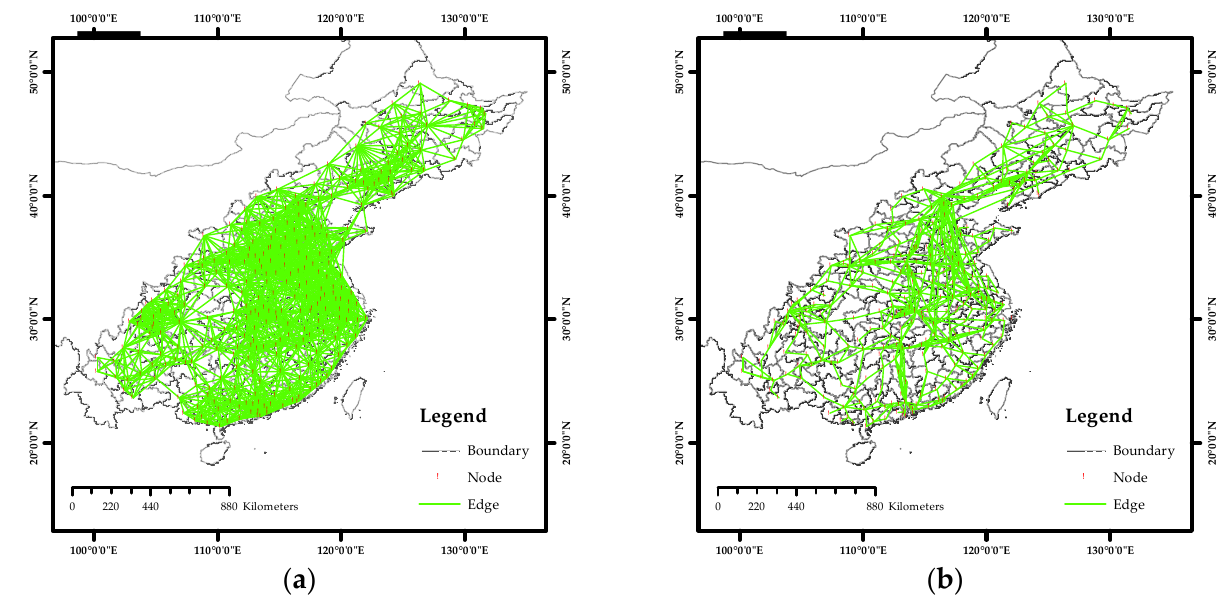
Figure 8. Single ‐ source urban network. ( a ) The nighttime light urban network; ( b ) The railway urban network.